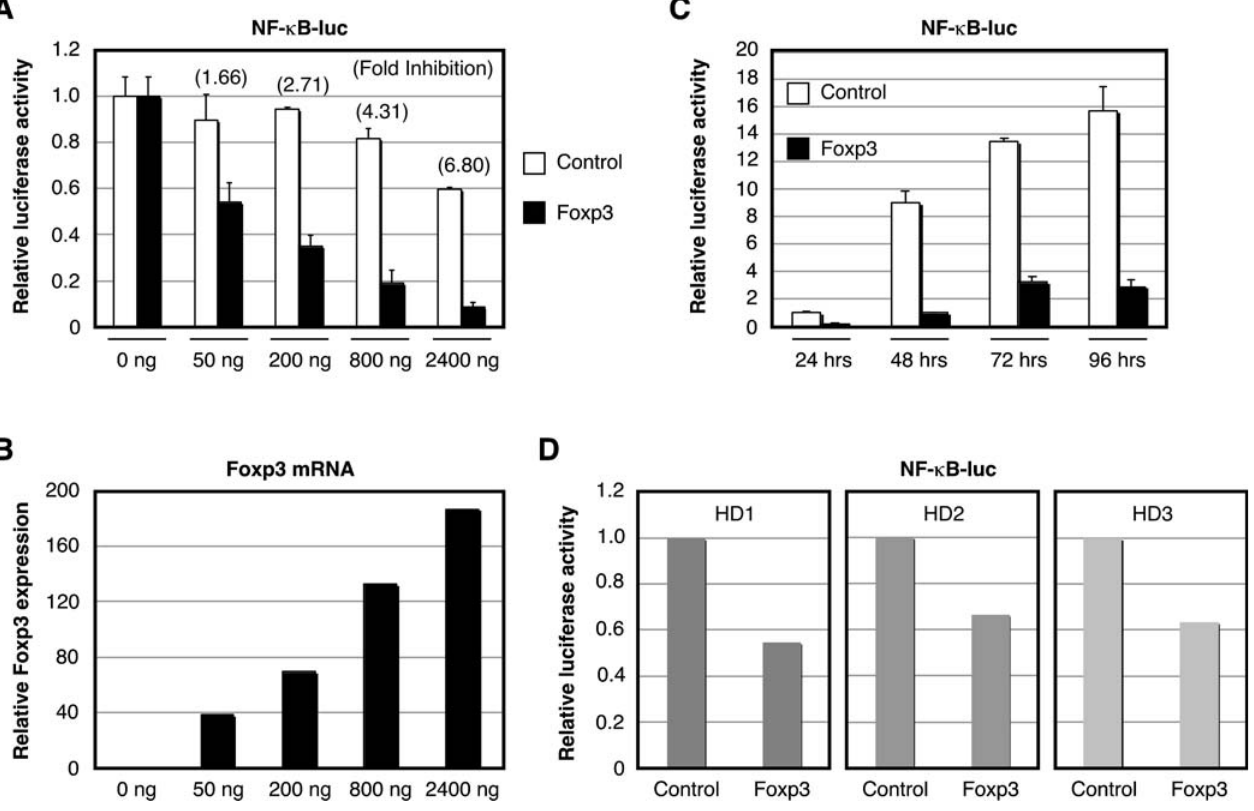
Figure 1. Foxp3 Suppresses NF- j B-Dependent